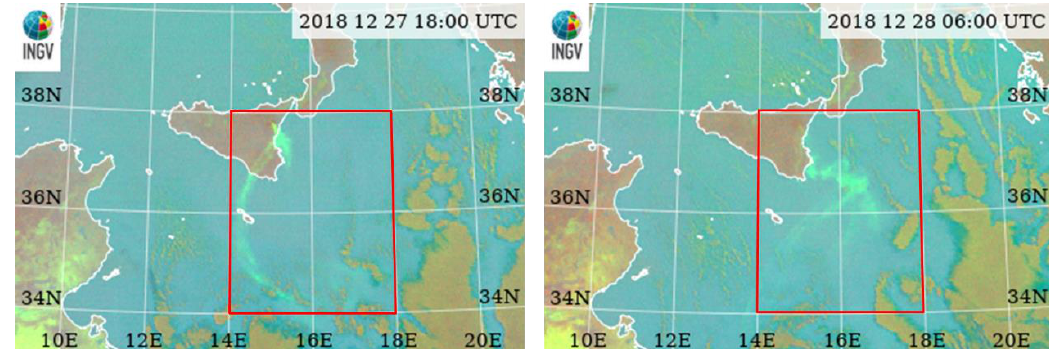
Figure 4. Red rectangle: area selected for the SO 2 total mass and flux cross-comparison. The two satellite images collected on 27 and 28 December 2018 at 18:00 and 06:00 UTC, respectively, are representative of the higher volcanic cloud extension detected from SEVIRI in the whole 26–30 December period.